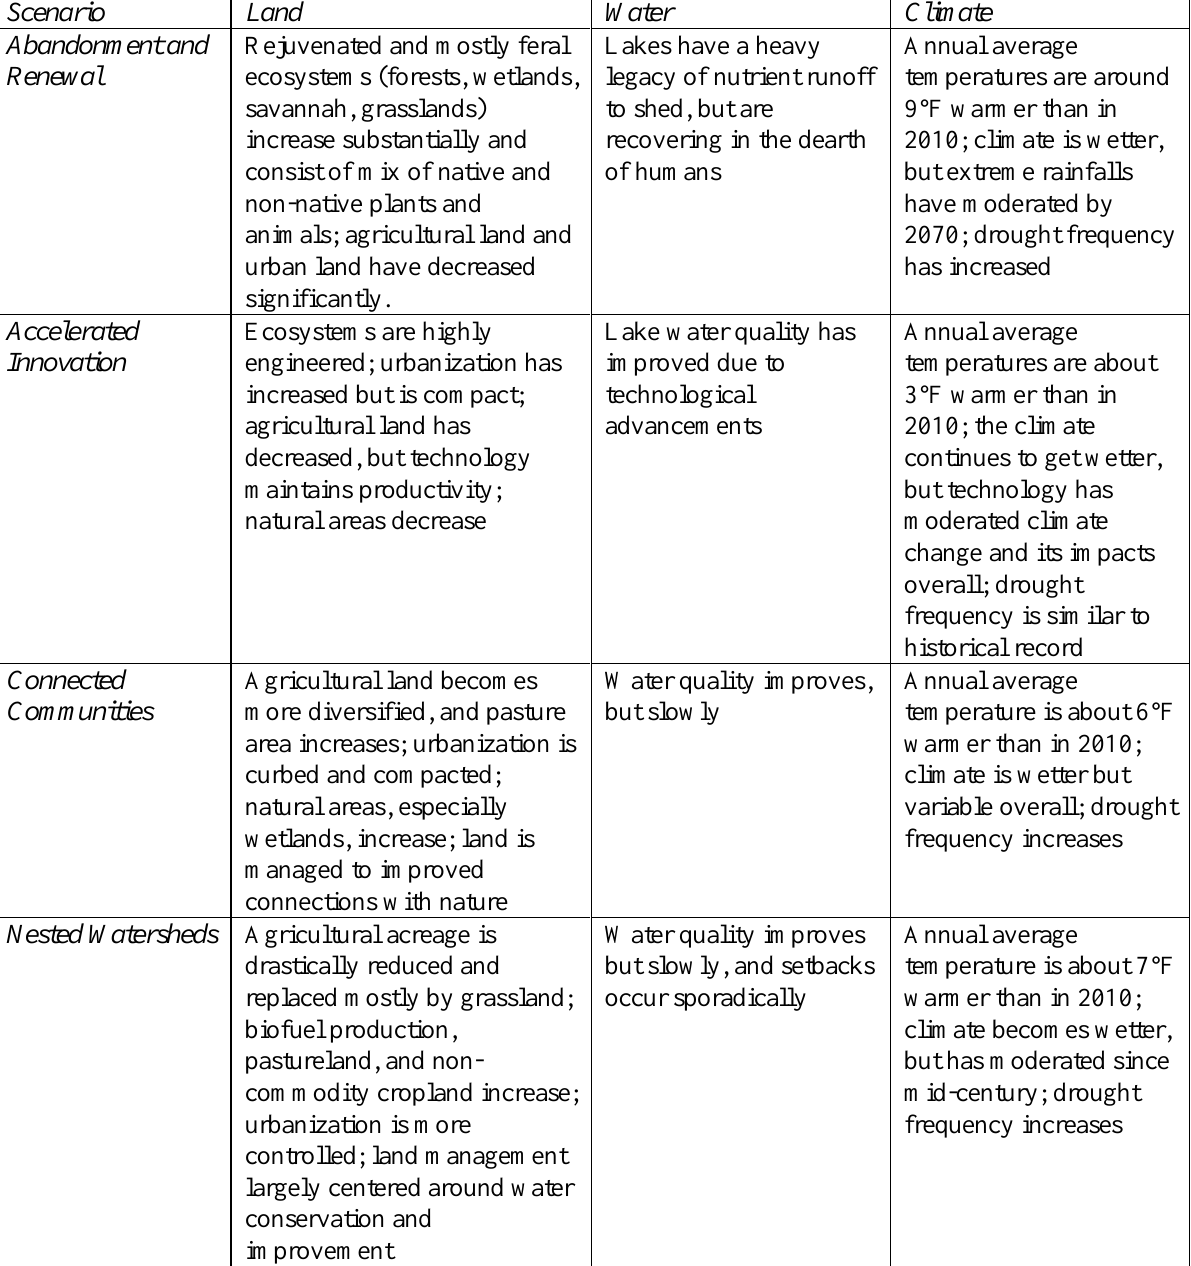
Table A1.2. Ecological Outcomes in 2070